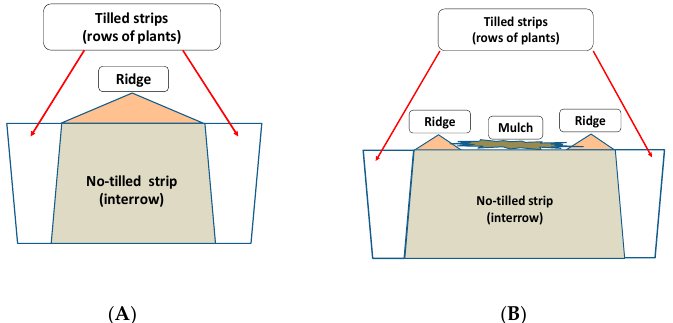
Figure 2. Field area after sowing plants in the strip-till one-pass technology (scheme) using the Mzuri Pro-Til hybrid machine. ( A ) With a tilled strip spacing of 36 cm; ( B ) With a tilled strip spacing of 72 cm